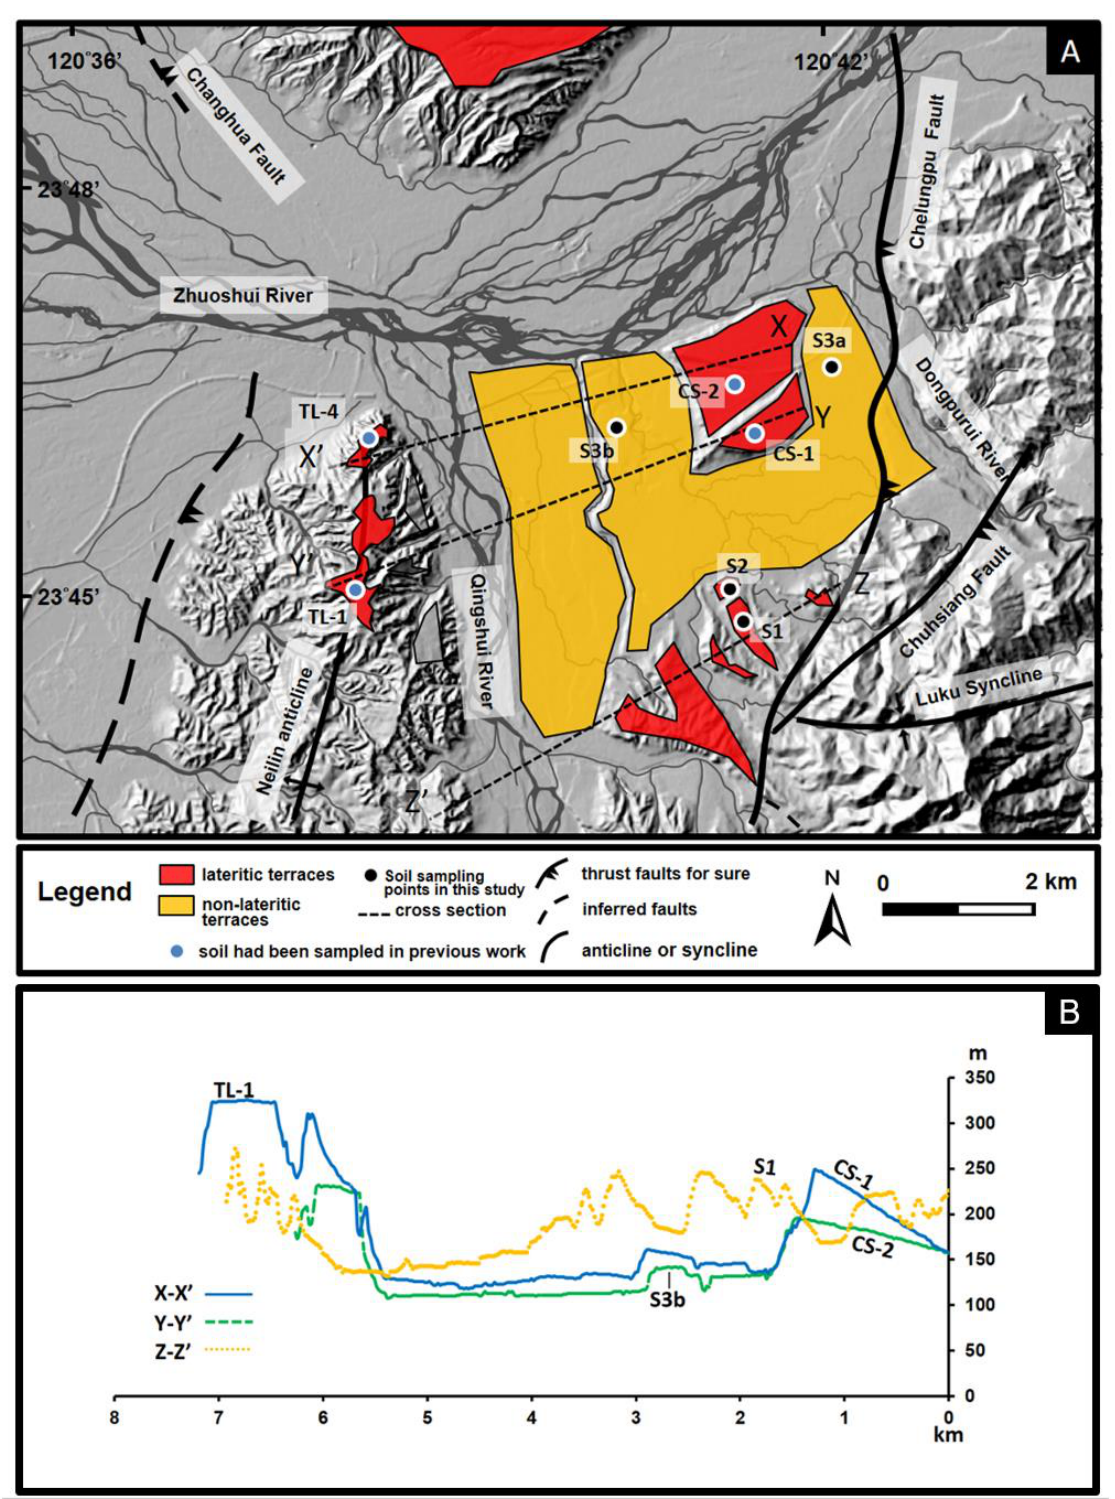
Figure 2. ( A ) Multiple-level terraces were formed in the mid reaches of the Zoushui River. Soils on the LT terraces are highly weathered and characterized by reddish color. Alternatively, soils on the latest-formed terraces are slightly weathered. The black dots show the soil sampling sites on the terraces. ( B ) The terraces have been deformed and tilted by the Changhua fault [22]. Soils are sampled on the terraces. We used abbreviations CS-1, CS-2, TL-1, S1, and S3b for naming soils and the names of terraces.